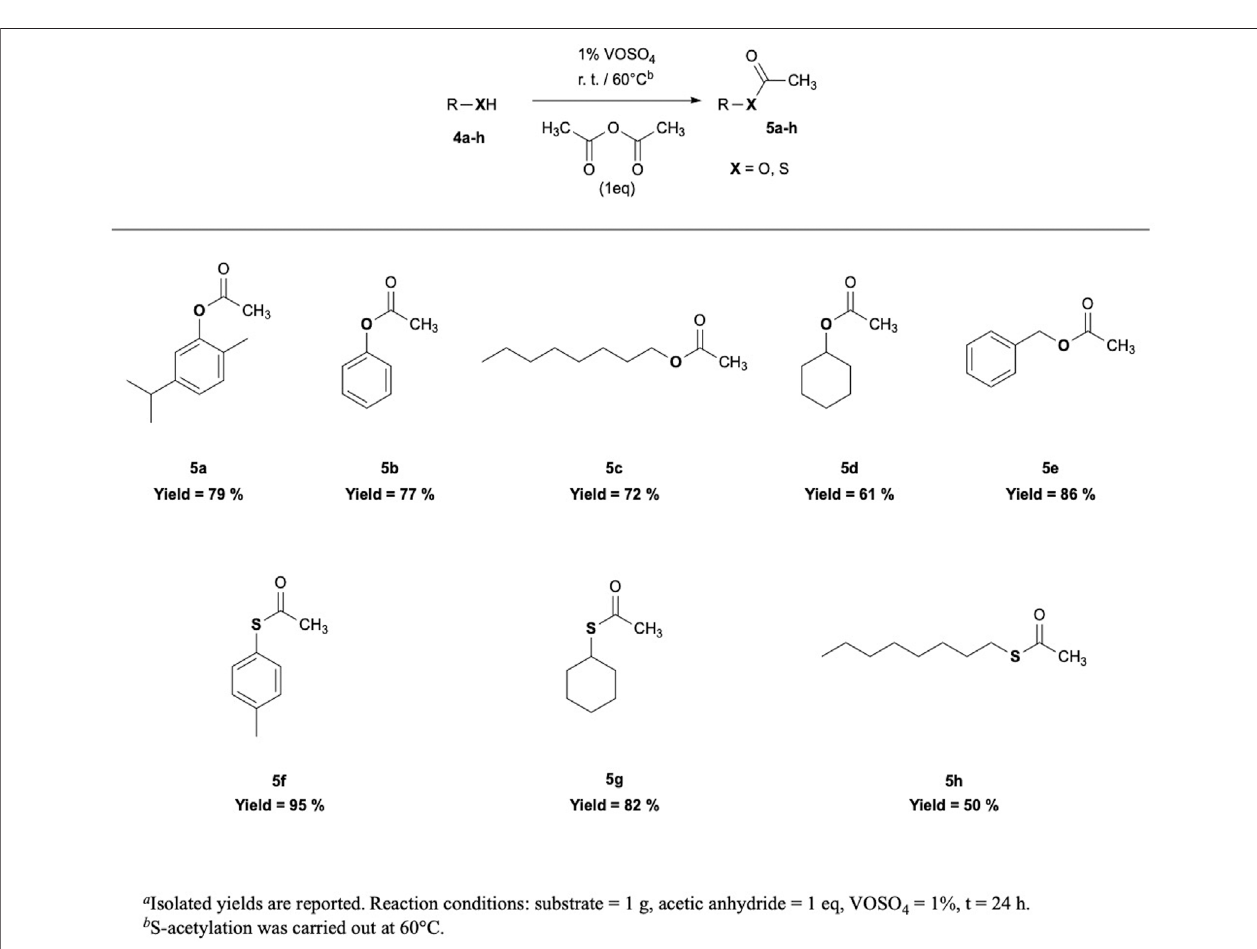
FIGURE 2 | O,S -acetylation reactions: substrate scope investigation.